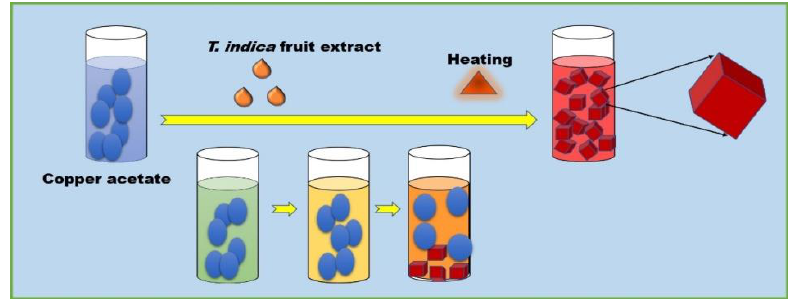
Figure 8. Mechanism of CuO NPs synthesis.